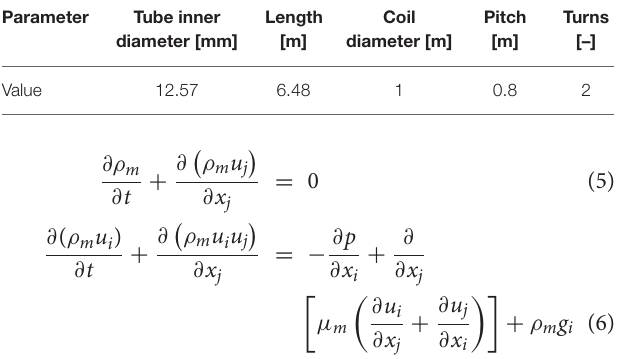
TABLE 1 | Geometric parameters of the helical